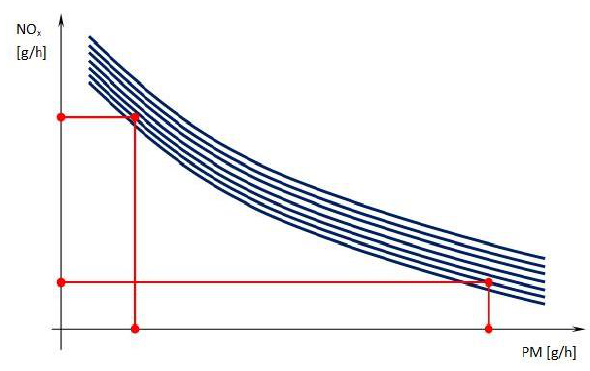
Fig. 17. Diagram of correlation between NO x and PM emissions [7]